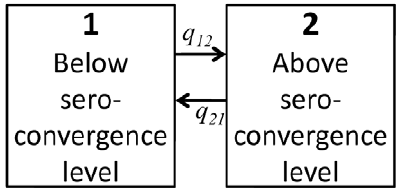
Figure 2. A multistate model describing transition of pigs through the states of immune response following challenge. At time t an individual is in state i . Its 2 states are labeled 1 and 2, denoting immune response below or above the seroconversion level, respec- tively.